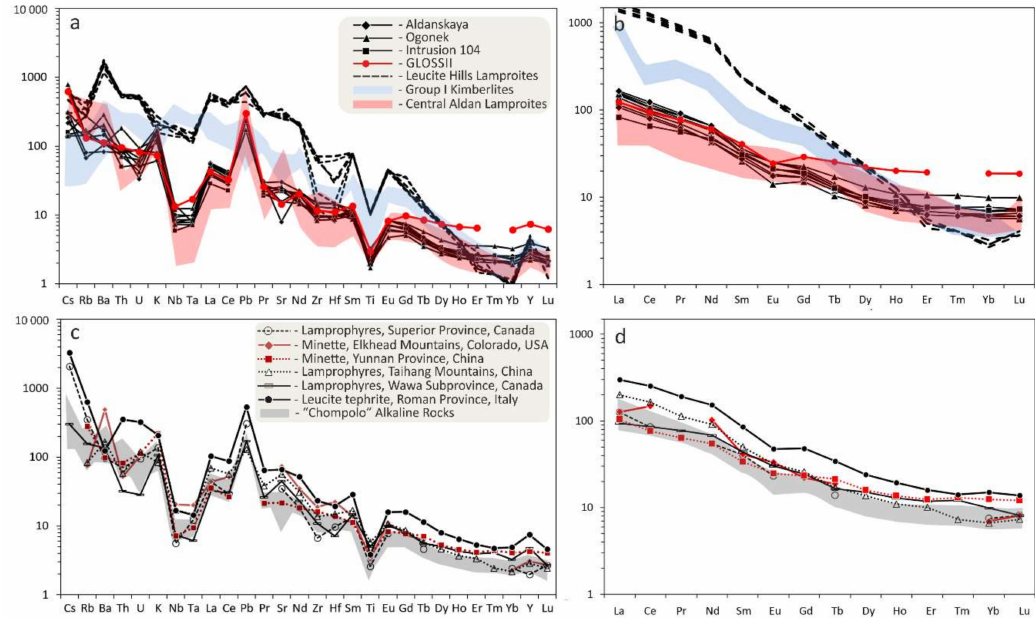
Figure 9. Primitivemantle(PM)-normalizedtraceelementabundances( a , c )[94], andchondrite-normalized rare earth element (REE) patterns [95] in Chompolo rocks (solid black line) ( b , d ). ( a ) Chompolo rocks together with lamproites from Leucite Hills (black dash line), according to [88]; group I kimberlites